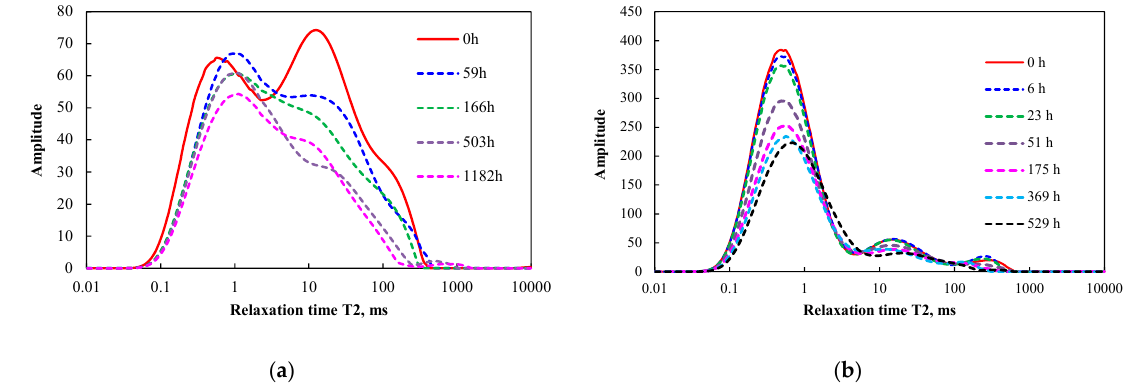
Figure 9. The T 2 spectra vs soaking time in UC7-2 and LC7-2 samples: ( a ) UC7-2 and ( b ) LC7-2.